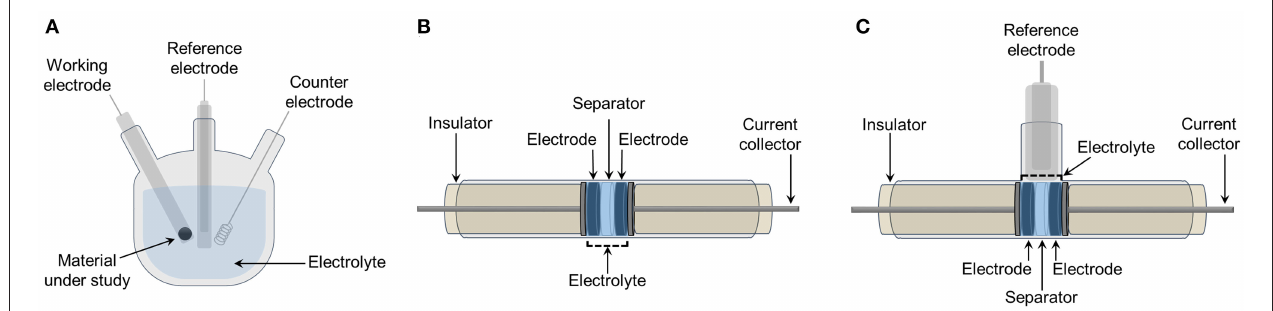
Figure 4A . During charging, the sharp increase in I at the beginning of the cycle is due to the rapid formation of the EDL and it remains constant when V increases because no Faradaic reaction occurs. Given the reversible nature of the EDL formation mechanism, the CV curve during discharge obtained when V decreases is the exact inverse of the charging curve. Evidently, the CV curves of the real SCs deviate from the ideal one, and those of PSCs also display I peaks due to the generation of charge by redox reactions, as shown in Figure 4A . In addition, widening the potential window in CV measurements allows identifying the point at which decomposition of the electrolyte occurs, manifesting by an I peak at each edge of the CV